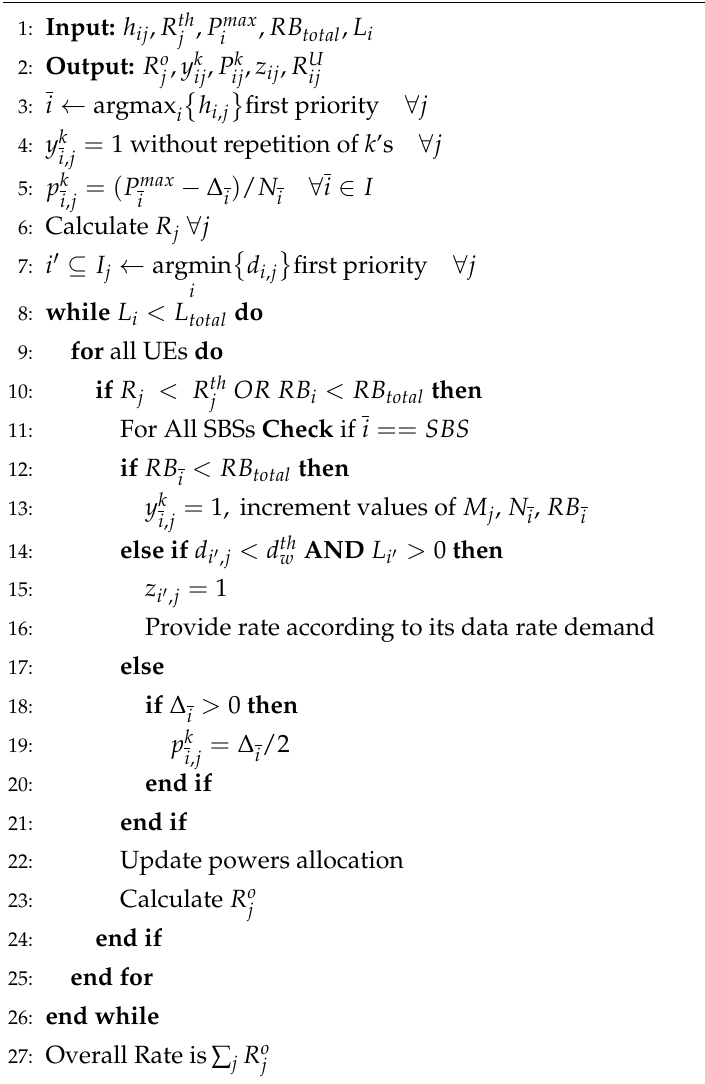
Algorithm 2 Sequential Offloading Rate Enhancement